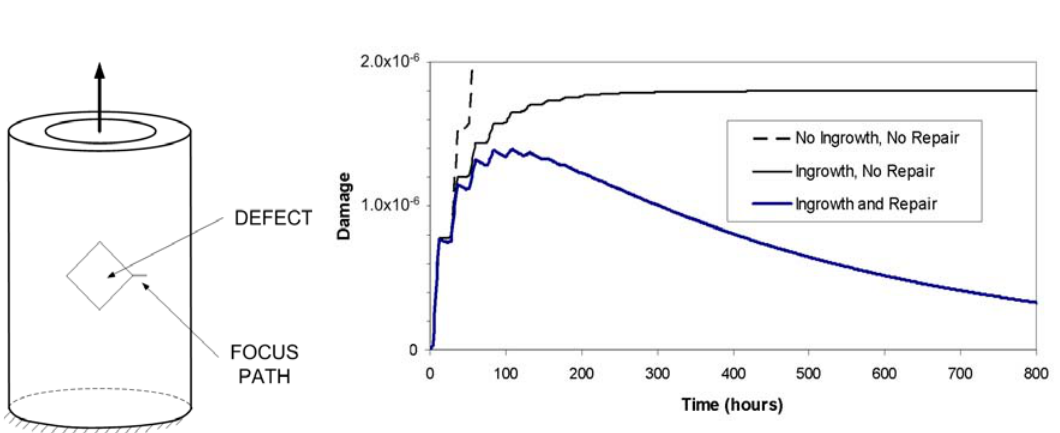
Figure 7: The geometry used to study defects of various shapes and sizes in a typical long bone – the focus path is the line on which TCD calculations are carried out. Typical predictions showing the effect on damage evolution of including ingrowth of bone into the defect, and bone repair processes.